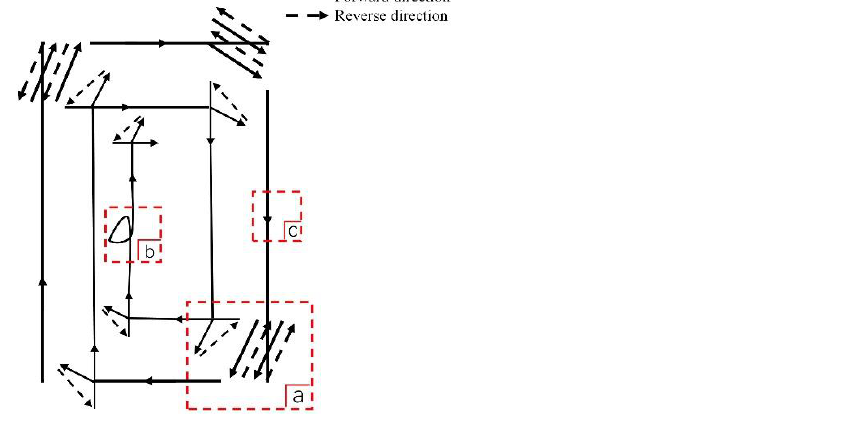
Figure 1. Schematic diagram of the trajectory of the wheat harvester in the field. ( a ) Turning trajectory, ( b ) abnormal working trajectory, and ( c ) working trajectory.